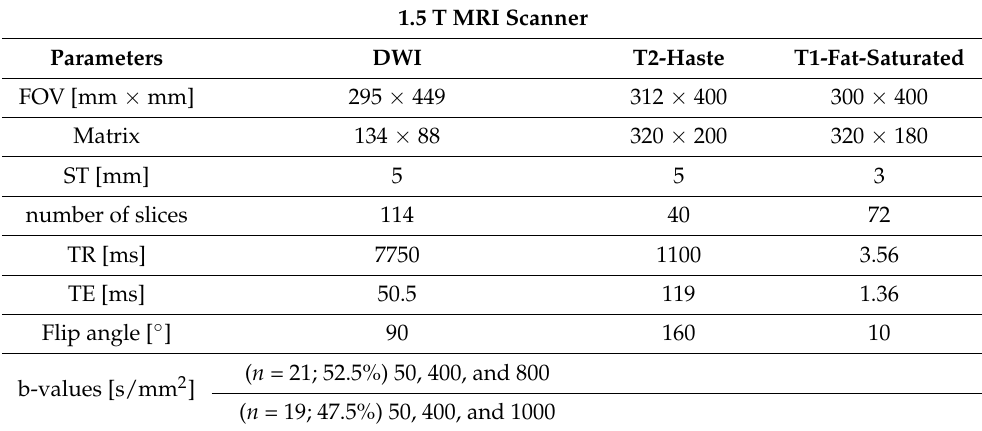
Table 1. Sequence parameters of axial diffusion-weighted imaging (DWI), T2-weighted and fat- saturated T1-weighted